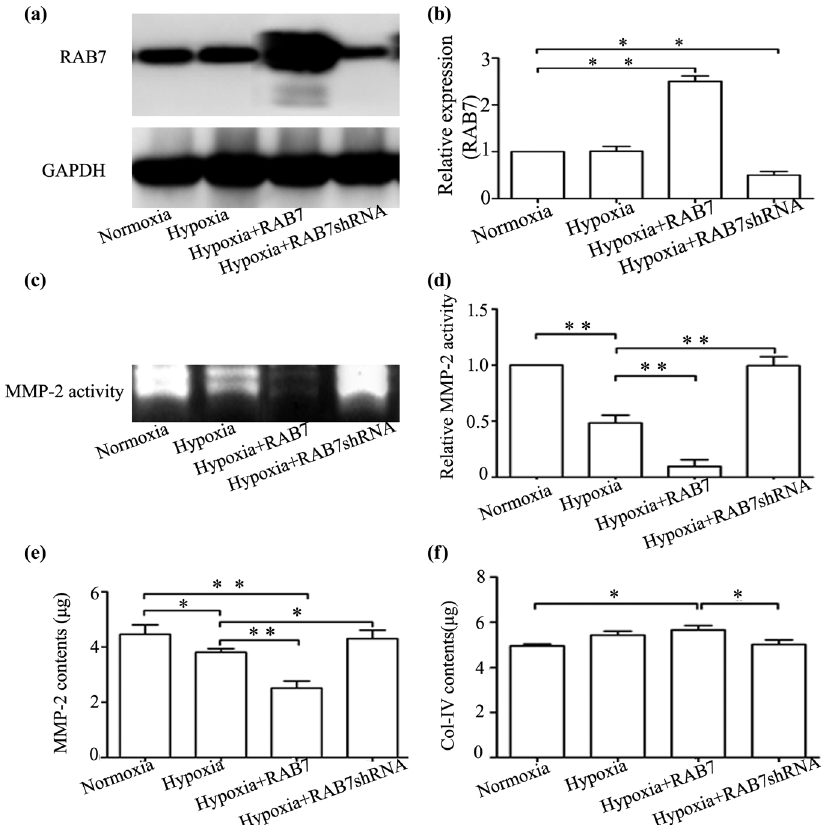
Figure 4: E ff ect of up - or downregulated RAB7 on MMP - 2 activity. ( a ) Up - or downregulated RAB7 expression in HK - 2 cells under hypoxia or normoxia was detected by western blot. The expression of RAB7 was signi fi cantly upregulated, and the expression of RAB7 was signi fi cantly downregulated compared to the control group. ( b ) Expression of RAB7 relative to that of GAPDH. ( c ) MMP - 2 activity in culture media was evaluated in HK - 2 cells with up - or downregulated RAB7 expression under hypoxia or normoxia by gel zymography, respectively. MMP - 2 activity was signi fi cantly higher in the group in which RAB7 was downregulated than in the hypoxia group. ( d ) Gels were scanned and quanti fi ed by densitometry and the relative MMP - 2 activity was calculated as a percentage of the relevant control values ( assigned values: 1 ) from arbitrary densitometry units. Data are the mean of three separative experiments. ( e ) The contents of MMP - 2 protein in cell culture supernatantswere detected by ELISA, respectively. The results were similar to the change inMMP - 2 activity inculture media. ( f ) The contents of Col - IV protein in cell culture supernatants were detected by ELISA, respectively. The results were reversed for MMP - 2 protein in the culture media. Error bars represented mean ± SD, and the results were analyzed by unpaired with Student ’ s t - test, * p < 0.05, ** p <